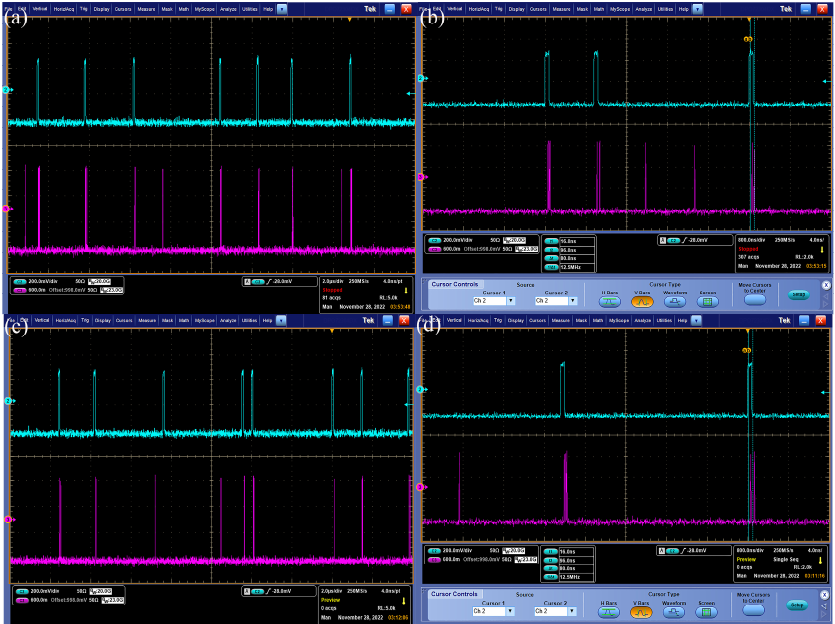
Figure 12. The signal sampled by the oscilloscope at the sampling rate was 250 MS/s: the display resolution of the oscilloscope is 2.0 µ s/div ( a ) and the display resolution of the oscilloscope is 800.0 ns/div ( b ) at a received optical power of − 76 dBm; the display resolution of the oscilloscope is 2.0 µ s/div ( c ) and the display resolution of the oscilloscope is 800.0 ns/div ( d ) at a received optical power of − 84